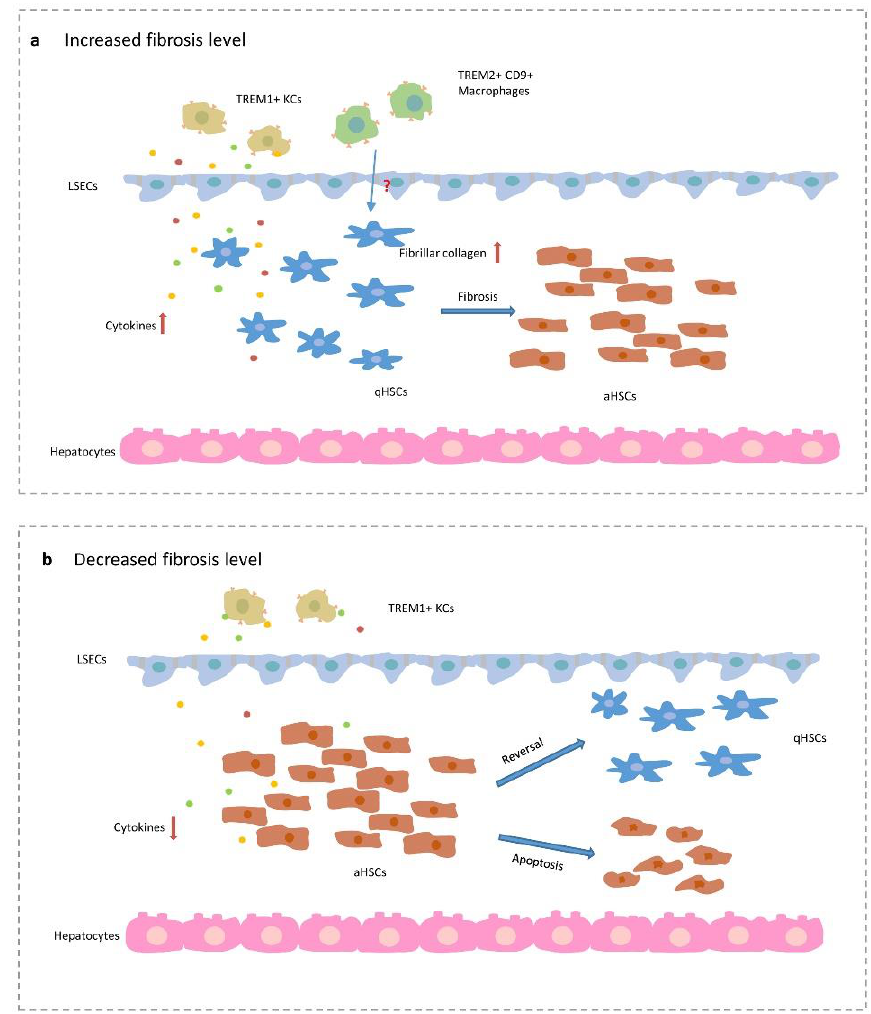
Figure 2. The function of TREM1 and TREM2 in fibrosis based on inflammation. ( a ) In pro-fibrogenic process, TREM1 expressed on Kup ff er cells promotes the activation of hepatic stellate cells by increasing cytokines. TREM2 + CD9 + macrophages also upregulate fibrillar collagen expression. ( b ) The decreased expression of TREM1 in KCs reduces cytokines and weakens the activation of quiescent hepatic stellate cells. In the low inflammatory level, activated hepatic stellate cells reverse into quiescent state and apoptosis. TREM, triggering receptors expressed on myeloid cells; LSECs, liver sinusoidal endothelial cells; aHSCs, activated hepatic stellate cells; qHSCs, quiescent hepatic stellate cells; KCs, Kup ff er